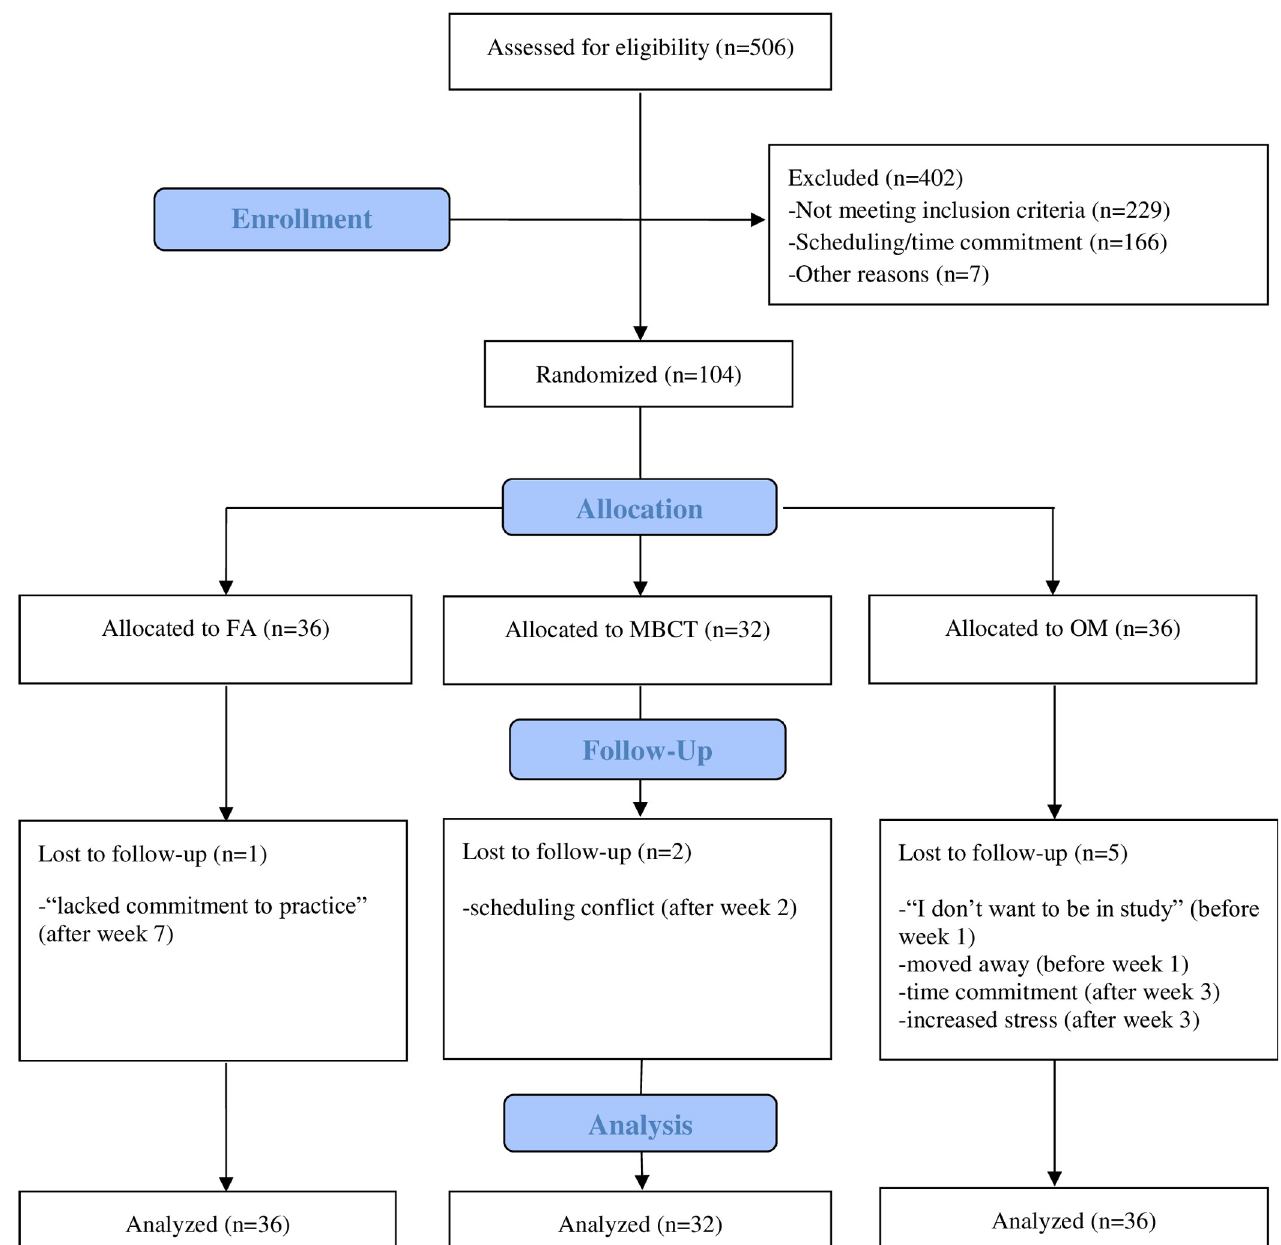
Fig 1. Participant flow. FA = Focused attention; MBCT = Mindfulness-based cognitive therapy; OM = Open monitoring.